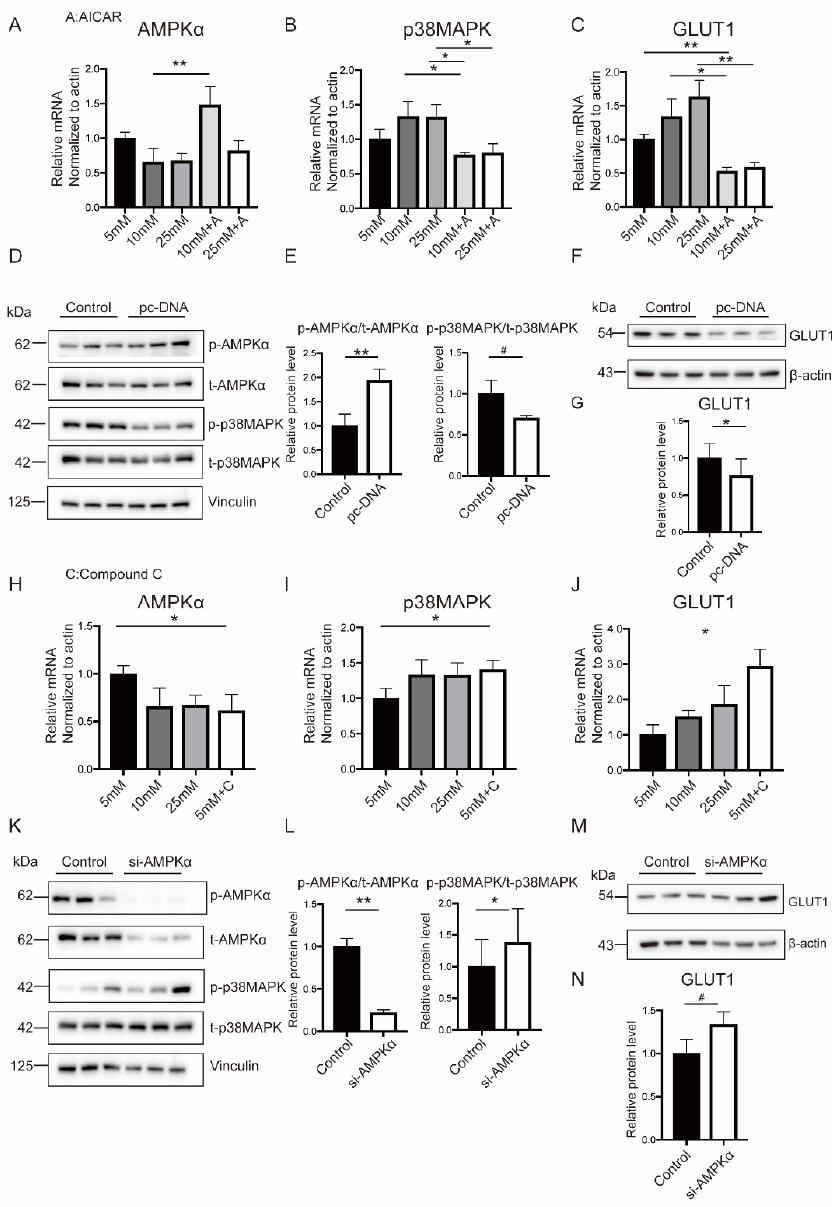
Figure 6. p38MAPK modulates glucose uptake and OS responses in an AMPK α -dependent manner. ( A – C ) Cellular mRNA levels of AMPKα ( A ), p38MAPK ( B ), and GLUT1 ( C )) in BeWo cells treated with the AMPKα agonist. ( D – G ) Cellular protein levels of AMPKα, p38MAPK, and GLUT1 in BeWo cells transfected with negative or AMPKα-DN plasmid. ( H – J ) Cellular mRNA levels of AMPKα ( H ), p38MAPK ( I ), and GLUT1 ( J )) in BeWo cells treated with the AMPKα inhibitor. ( K – N ) Cellular protein levels of AMPK α , p38MAPK, and GLUT1 in BeWo cells transfected with siRNA against SEM. # p < 0.1, * p < 0.05, and ** p < 0.01 by a one-way ANOVA test, followed by a post hoc test. A: AICAR. C: Compound 2.7. Trp53, Mknk2, Myc, and HIF1-α targeted on p38MAPK involving in GLUT1 regulation